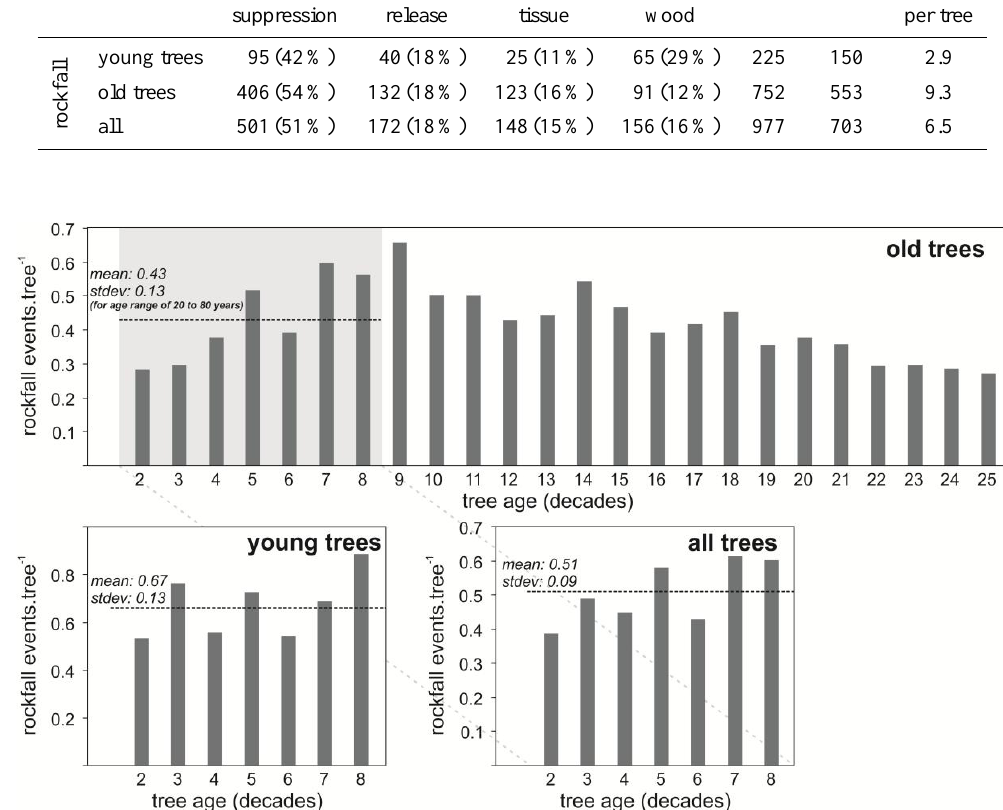
Figure 3: Evolution of the number of recorded rockfall events per one tree in individual tree age